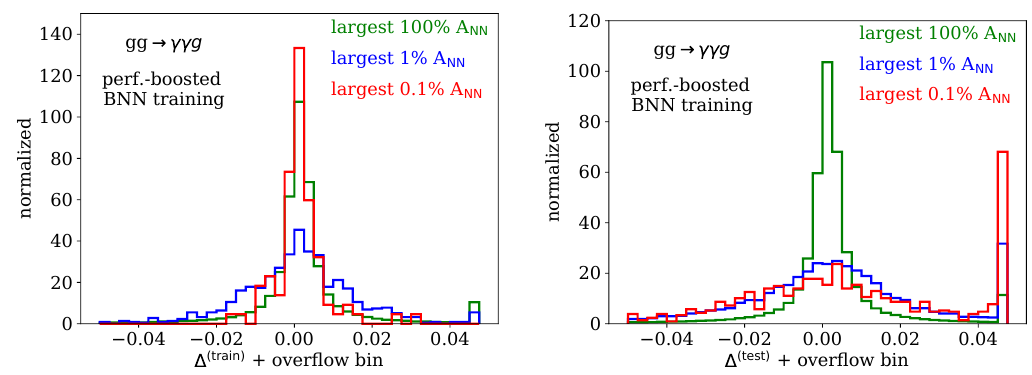
Figure 9: Performance of the performance-boosted BNN in terms of the precision of the generated amplitudes, Eq.(3), evaluated on the training (left) and test datasets (right). All curves can be compared to the BNN results without boosting in Fig. 2 and the loss-boosted results in Fig.